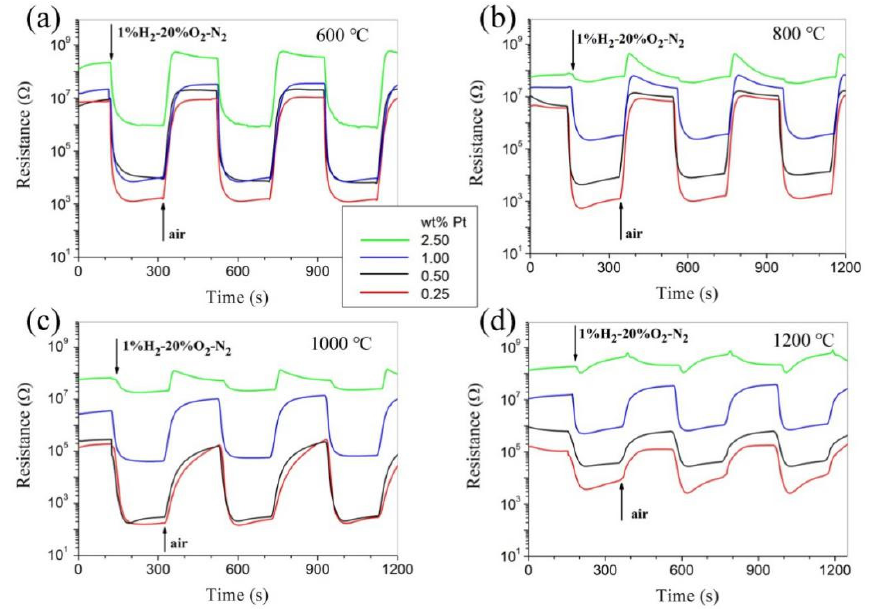
Figure 5. Room-temperature responses to 1.0% H 2 -20% O 2 -N 2 for Pt-SnO 2 nanoceramics sintered at a series of temperatures, separately: ( a ) 600 °C. ( b ) 800 °C. ( c ) 1000 °C. ( d ) 1200 °C.